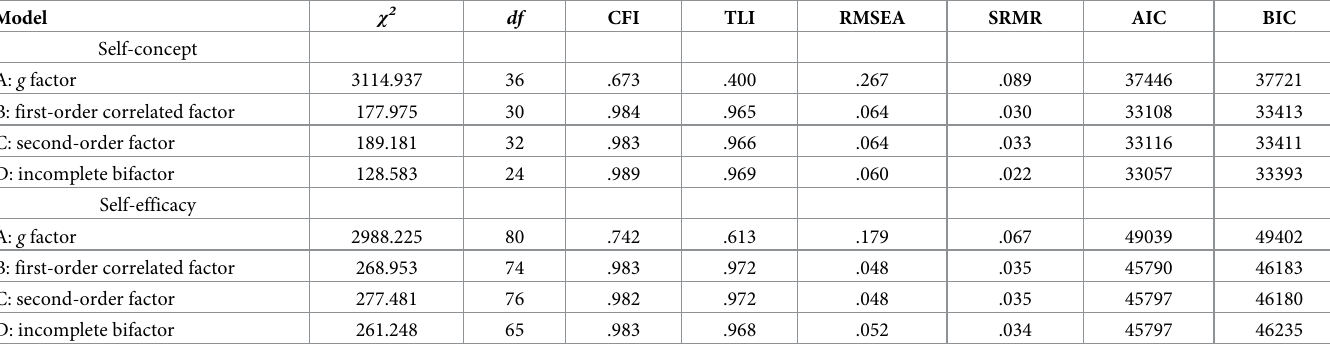
Table 3. Goodness-of-fit indices of alternative CFA models for ability self-concept and self-efficacy.